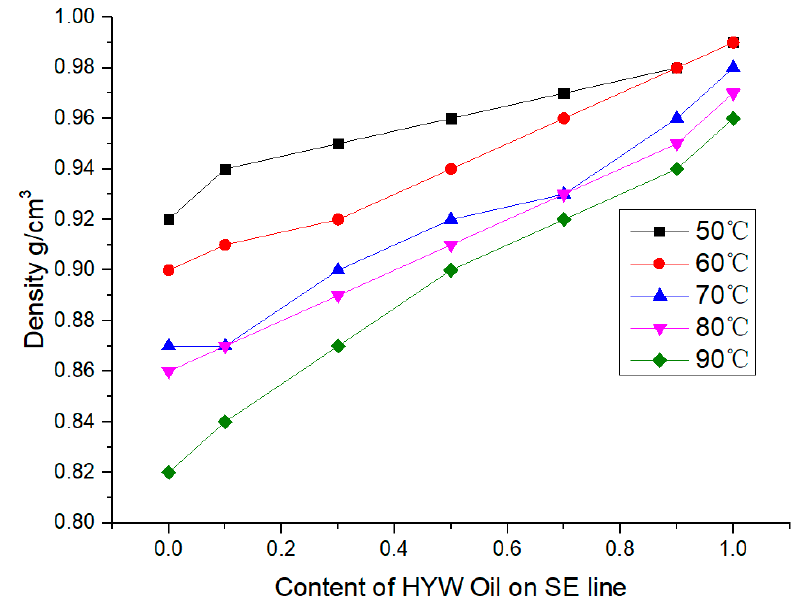
Figure 3. The impact of current density on density.